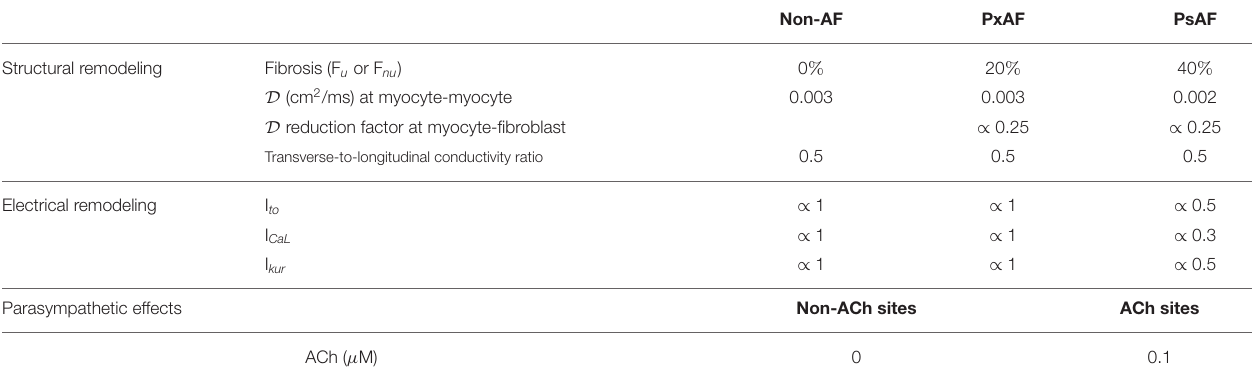
TABLE 1 | Characteristics of electrical and structural remodeling in non-atrial fibrillation (AF), paroxysmal-AF, and persistent AF (PsAF) tissues, and simulated ACh